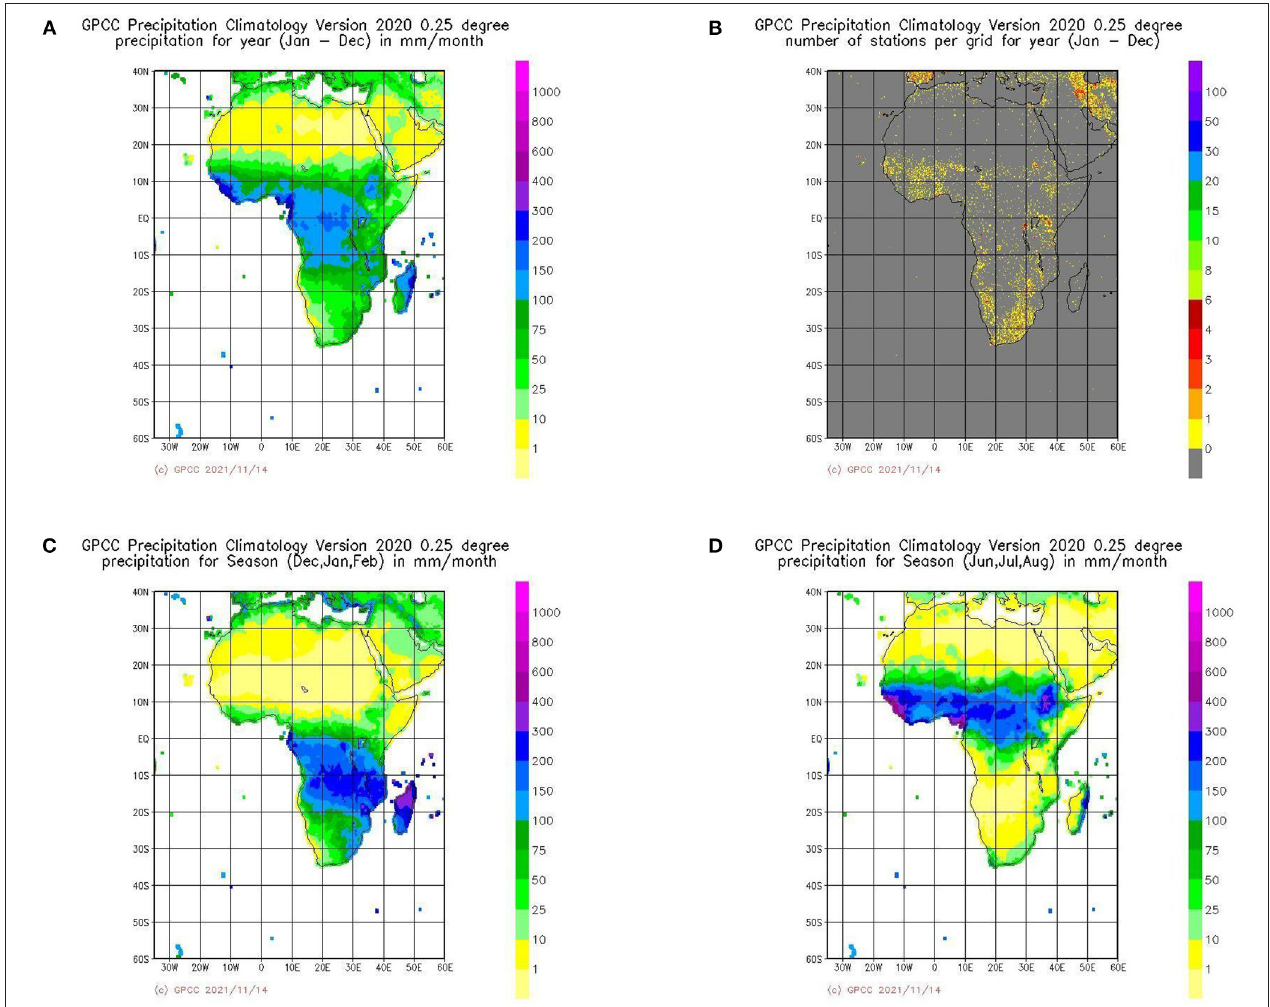
FIGURE 6 | (A) Long term annual mean precipitation in Africa according to GPCC climatology - version 2020. (B) Number of stations per 0.25 ◦ grid cell used for the production of the climatology - (C) Long term mean precipitation for the season December, January, February. (D) Long term mean precipitation for the season June, July, August in Africa